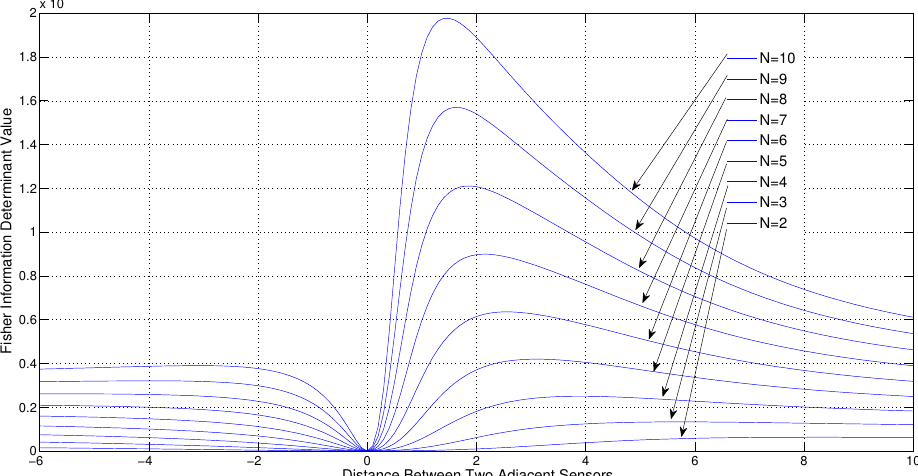
Figure 8. Variation of Fisher information determinant value with the distance between two adjacent sensors of ULA for different number of range sensors (One sensor